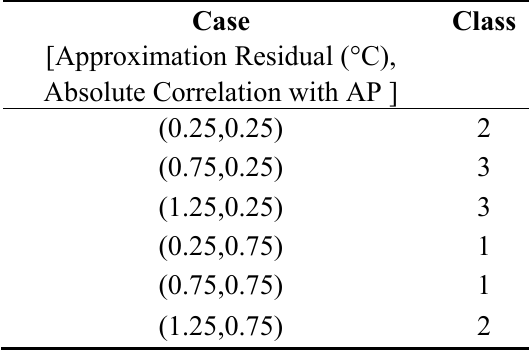
Table 1. Training 2D RBF classifier for temperature